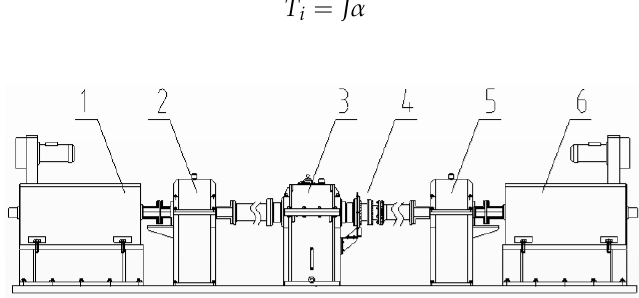
Figure 13. Structure of the electric inertia calibration test bench.